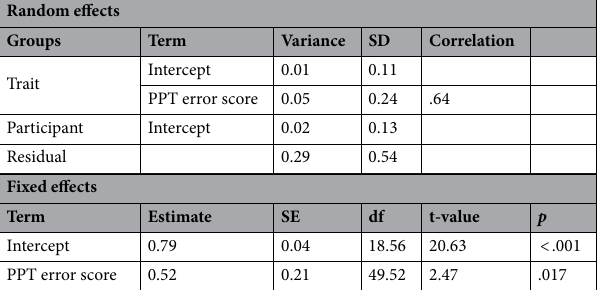
Table 3. Model summary for predicting error in trait